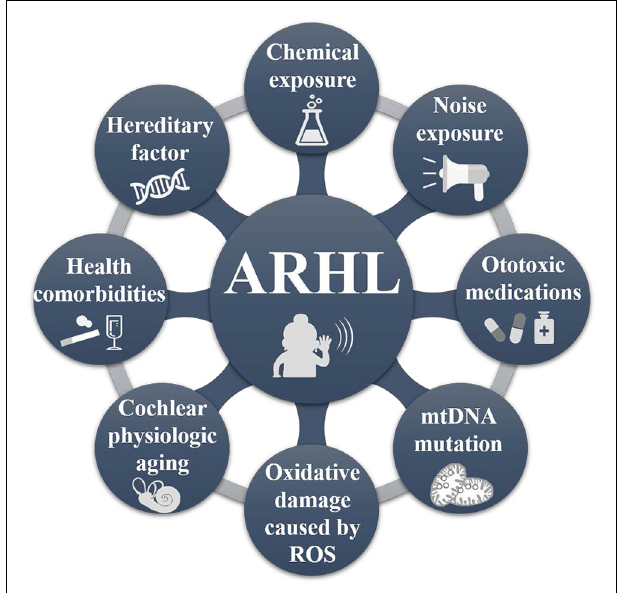
FIGURE 1 | The pathogenic factors of age-related hearing loss (ARHL). ARHL is a multifactorial disease, mainly caused by external environmental factors (e.g., noise and exposure to chemical factors, ingestion of ototoxic medications, intake of hormones, alcohol, nicotine, etc.); mitochondrial